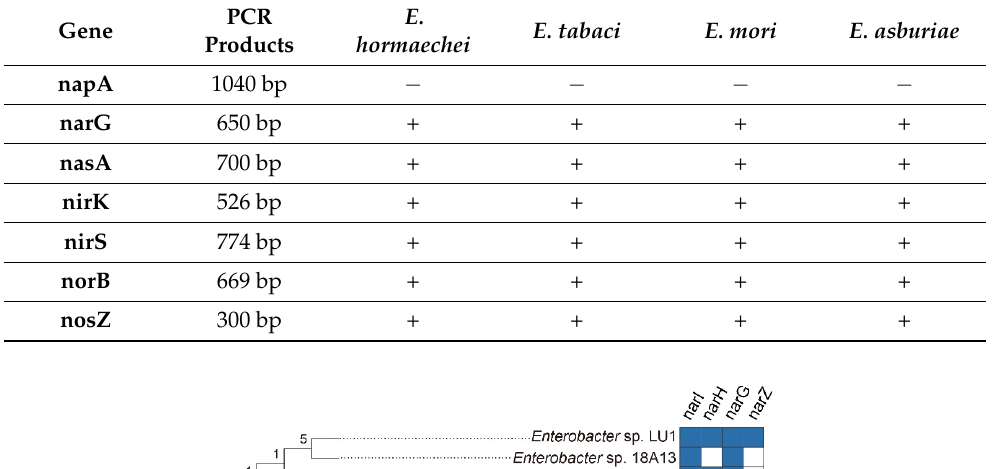
Table 2. Genes linked to denitrification and nitrate reduction harbored in the genomes of strains affiliated with Enterobacter .